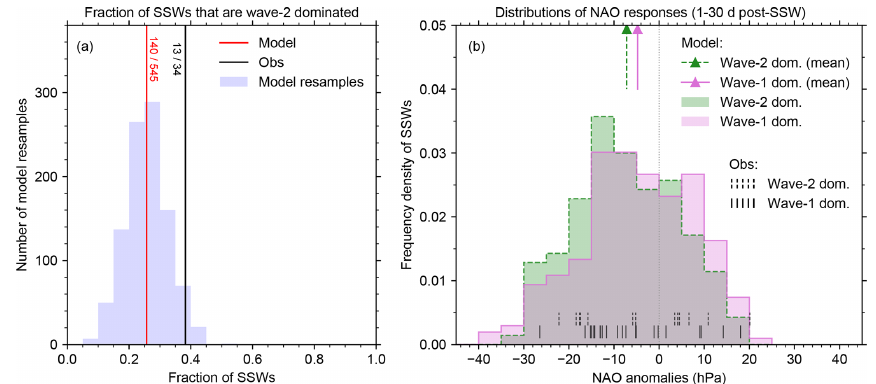
Figure 6. Frequency of wave-2-dominated SSWs and their NAO responses. Panel (a) shows the frequency of wave-2-dominated SSWs in the model and observations (vertical lines) and the distribution in the model resamples (histogram), in a similar format to Fig. 1b. Panel (b) shows the normalised distribution of NAO responses across the wave-2- and wave-1-dominated SSWs (as labelled), in a similar format to Fig. 1c. The distributions in the model are shown as histograms, and observations are shown as vertical tick marks near the base of the plot, vertically separated for clarity. The mean responses in the model are marked with coloured arrows at the top of the